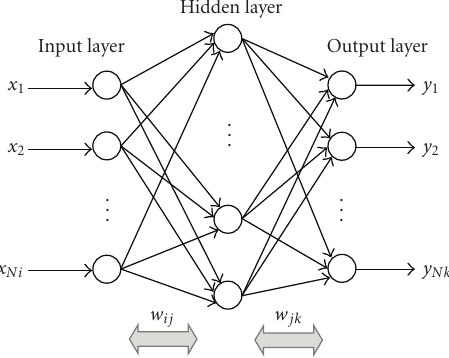
Figure 2: Schematic diagram of a general back-propagation neural